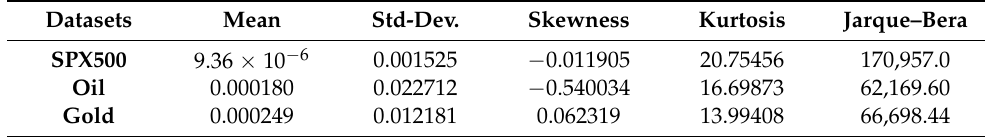
Table 1. Descriptive statistics of log return.